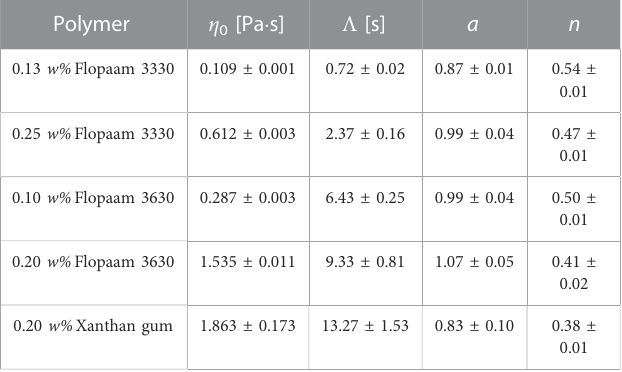
TABLE 1 Fitting parameters of Carreau – Yasuda model for viscosity Eq. 1: η 0 isthe zero-shear viscosity; Λ is acharacteristic time; a isa transition controlfactor;and n is the power law exponent associated with the degree of shear-thinning. η ∞ was fi xed to the solvent viscosity 0.001 Pa · s for all used polymer solutions. Polymer